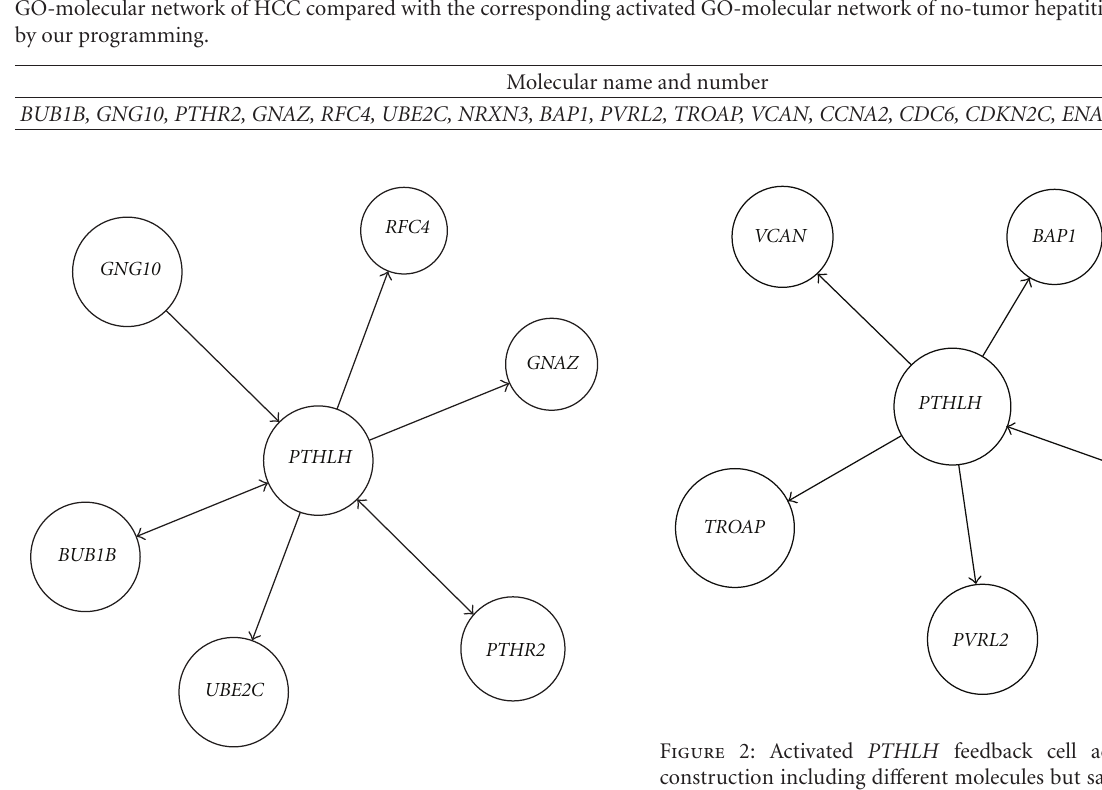
Figure 1: Activated PTHLH coupling feedback phosphoinositide to G-protein receptor signal network construction including di ff erent molecules but same GO term and same molecule but di ff erent GO terms in HCC from the same activated PTHLH GO-molecular network of HCC compared with the corresponding activated GO-molecular network of no-tumor hepatitis/cirrhotic tissues by GRNInfer and our programming.